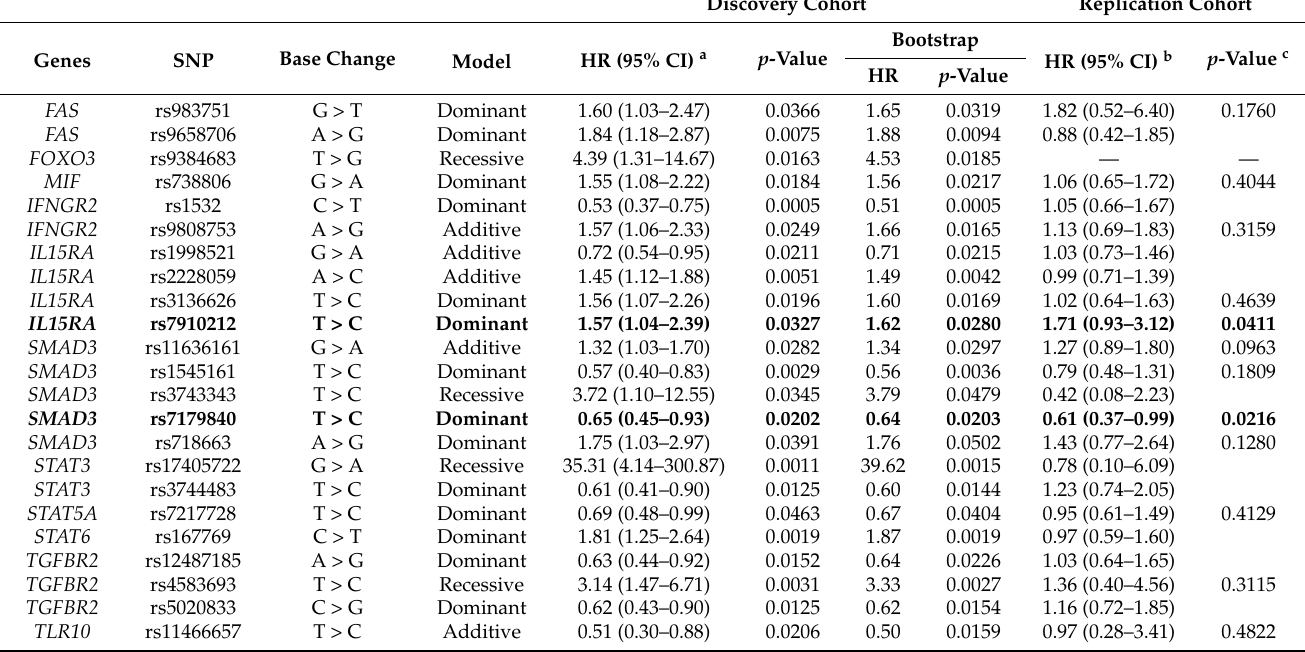
Table 2. Genetic markers and overall survival in the discovery ( n = 243) and replication ( n = 92) cohorts. Only the associations with p -value < 0.05 and Bootstrap p -value < 0.05 are reported for the discovery cohort. Replicated markers are in